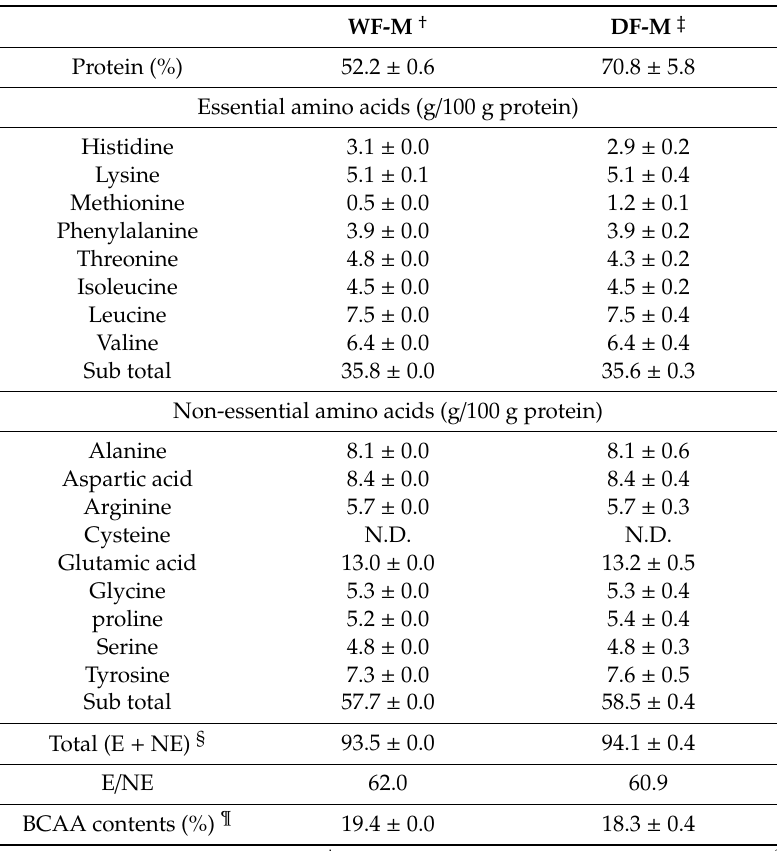
Table 1. Amino acids composition of whole-fat and defatted